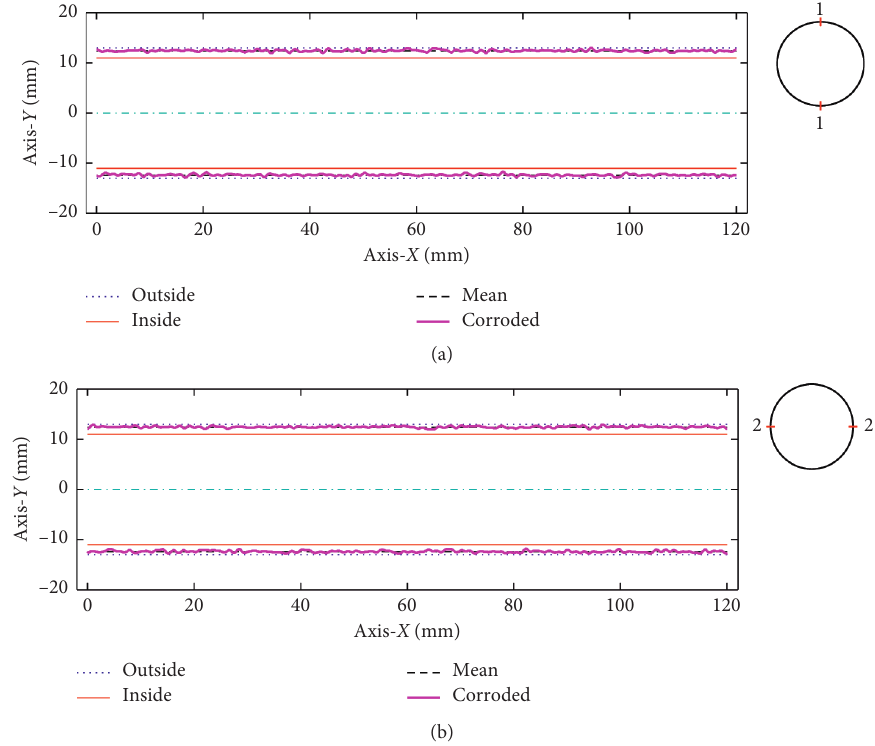
Figure 5: The topology of corroded section along the axis of pipe. (a) Section 1-1. (b) Section